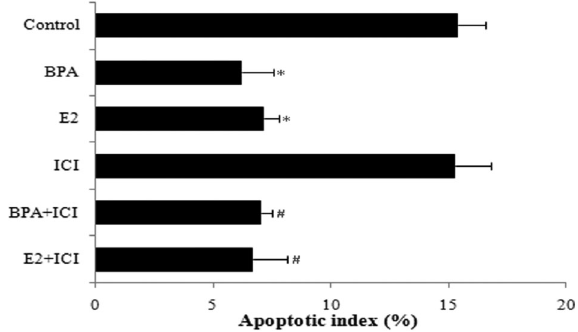
Figure 5. Apoptotic index of HepG2 cells treated with bisphenol A (BPA) or estradiol (E2) alone or in combination with the anti- estrogen ICI 182,780 (ICI) for 48 h. Data are reported as means ± SD. *P o 0.05 compared to control group; # P o 0.05 compared to ICI group (one-way